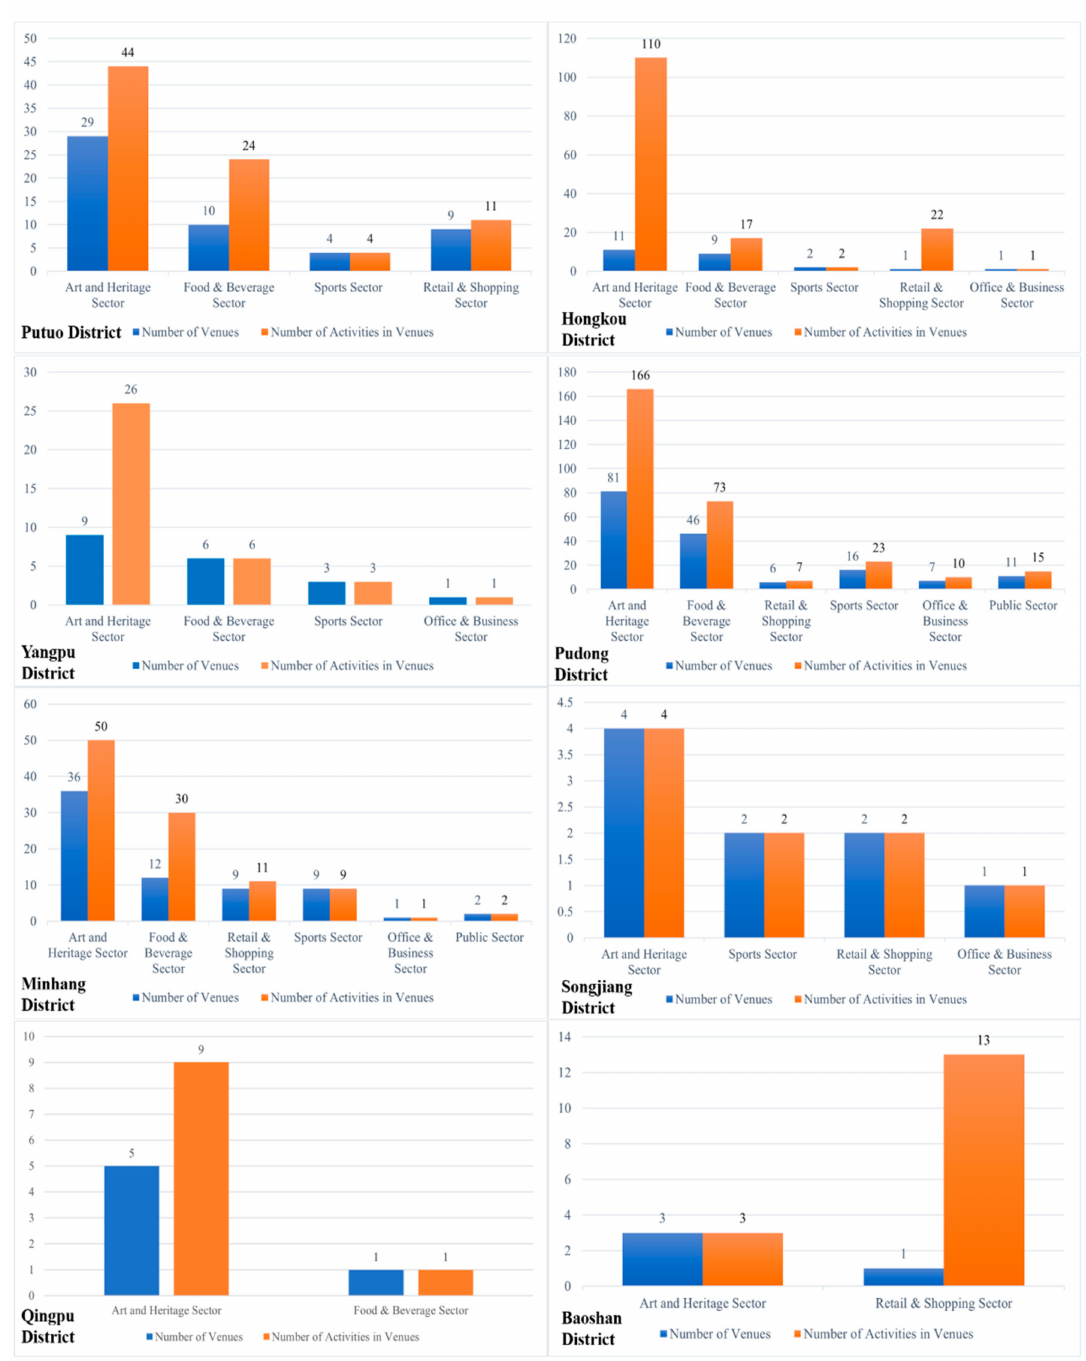
Figure 5. Functional breakdown of cultural venues in Putuo, Hongkou, Yangpu, Pudong, Minhang, Songjiang, Qingpu, and Baoshan